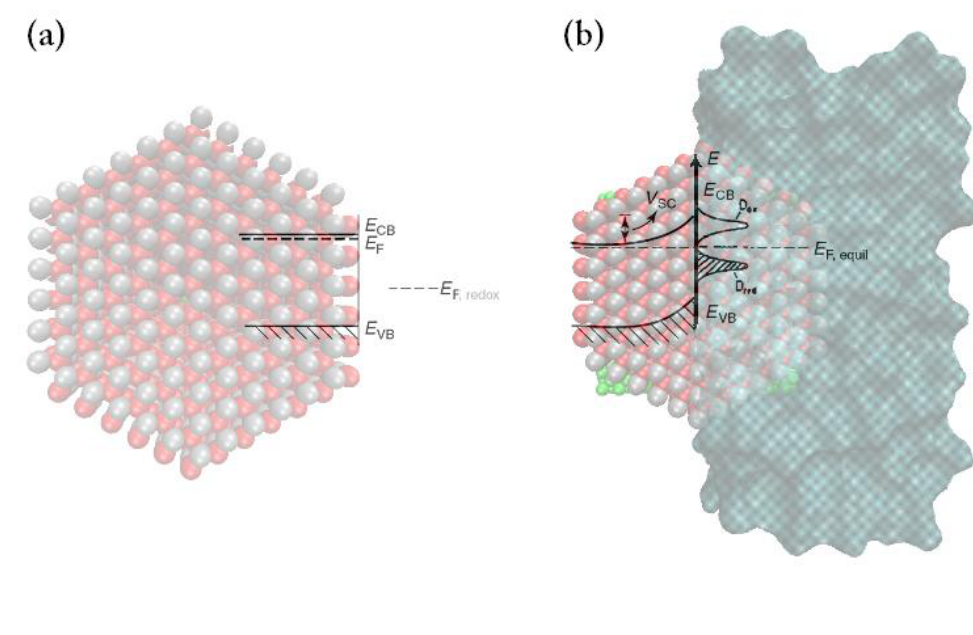
Figure 2. Energy levels of n-type ZnO before equilibrium (a) and the band bending in n-type ZnO electrode upon equilibration of the Fermi level of the semiconductor with the redox species